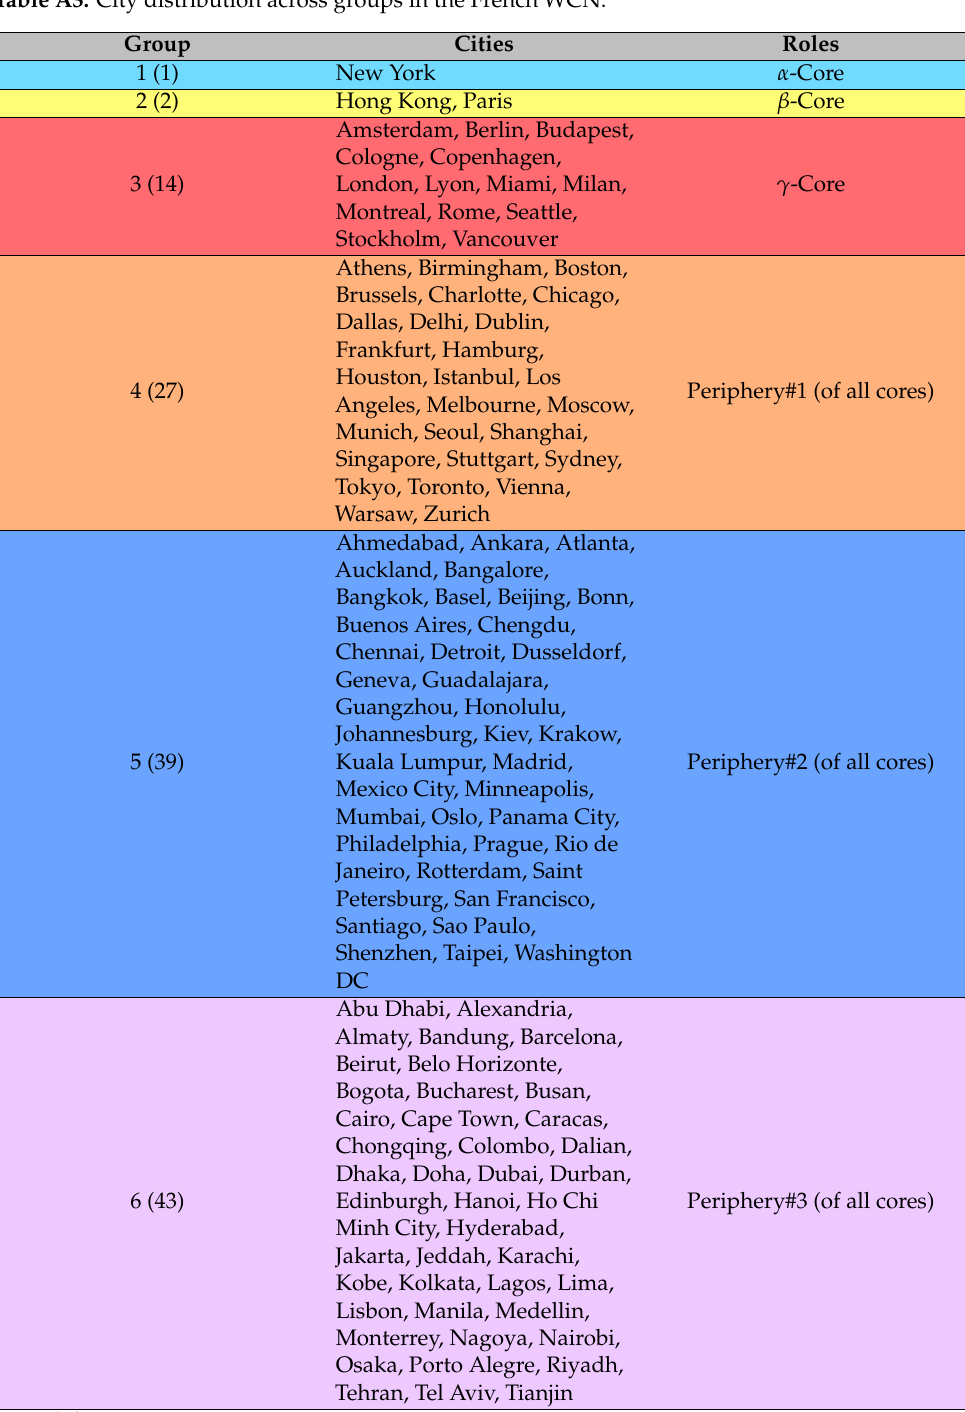
Note: Colors represent groups in Figure